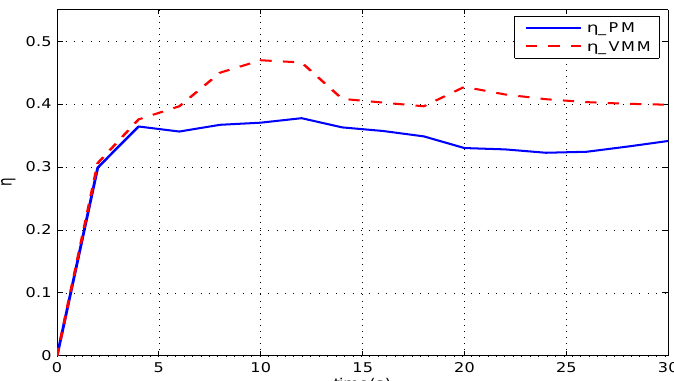
Figure 15. The efficiency in Karman